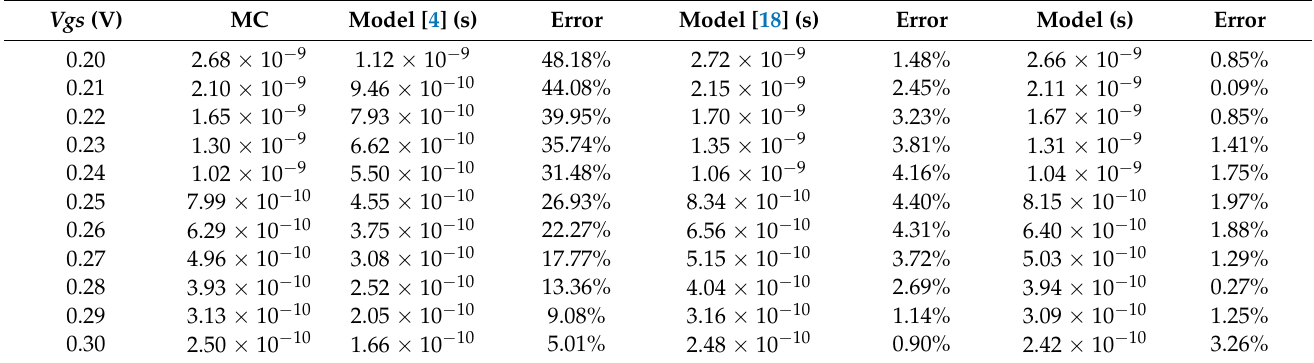
Table 18. Propagation delay at different voltages (T = 25 ◦ C, Cl = 0.5 fF, τ = 1 × 10 − 11 s, Vbs = 0).